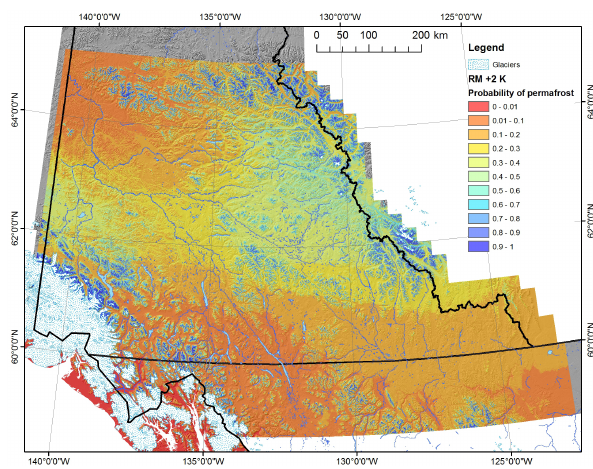
Fig. 5. Regional model permafrost probability map under a +1 K climate change scenario. Permafrost underlies 38% of the region under this scenario.